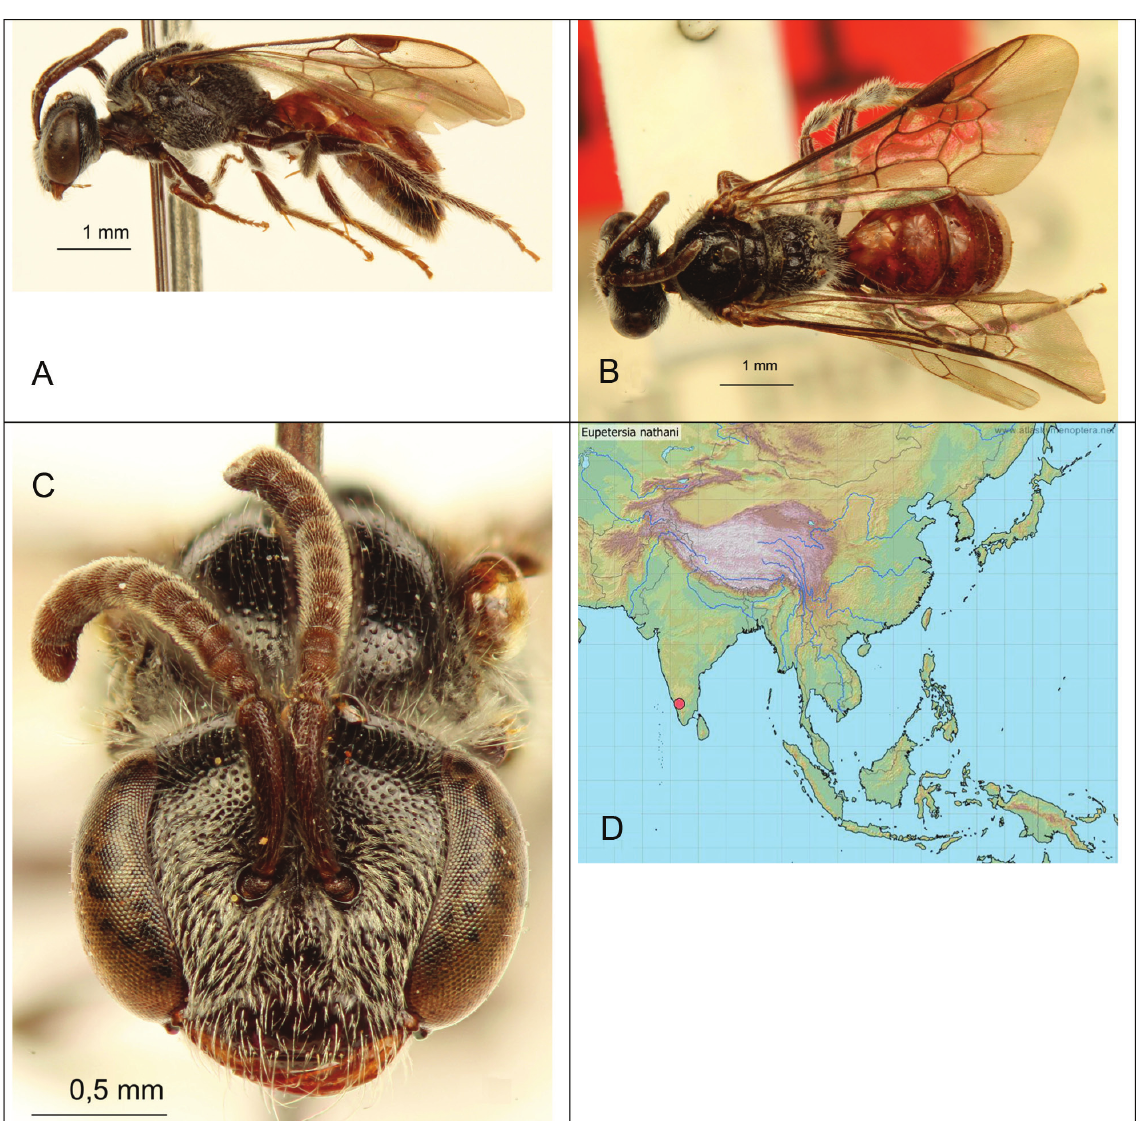
Fig. 3. Eupetersia nathani Baker, 1974, ♀ holotype. A . Lateral habitus. B . Dorsal view of habitus. C . Facial view. D . Geographic